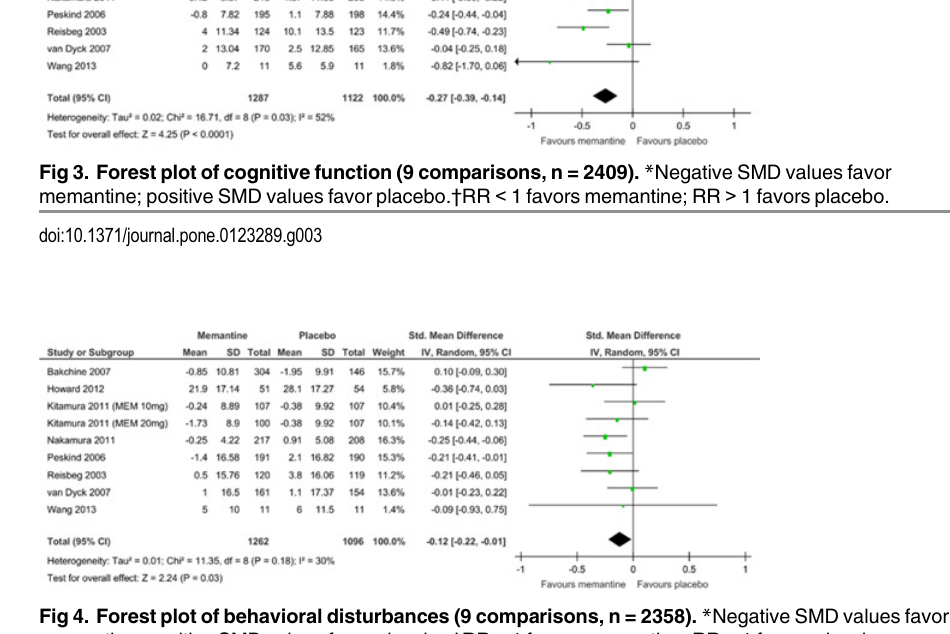
Table 2. Sensitivity analysis of the efficacy of memantine monotherapy (cognitive function). Variable